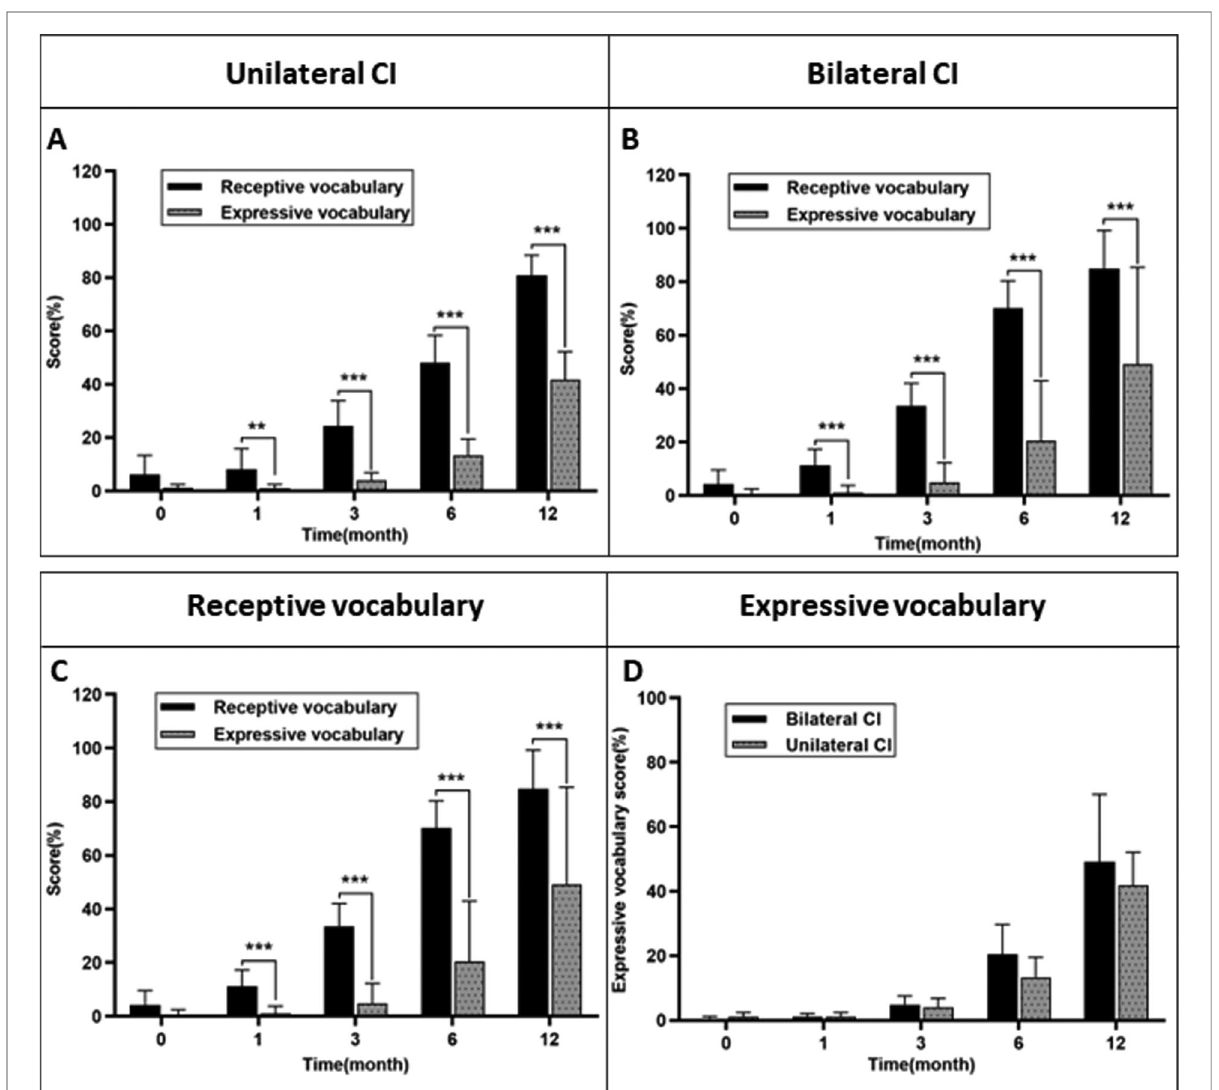
FIGURE 2 The mean scores of receptive and expressive vocabulary score in two groups. * p <0.05, ** p